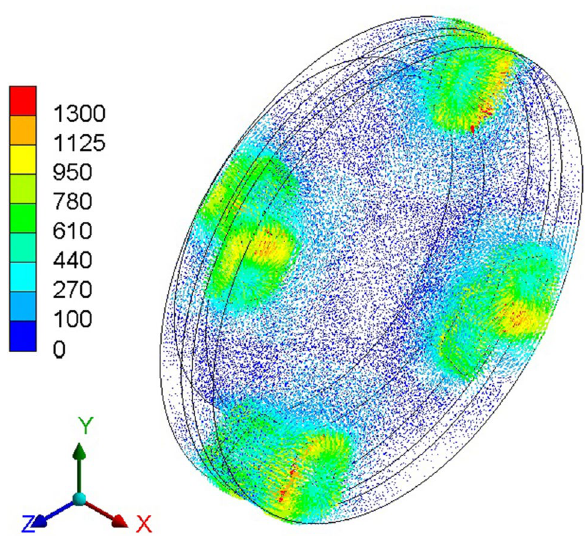
Fig. 7 Results of the magnetostatic simulation for gap 3 mm, Total magnetic flux density in mT . Maximum stop torque is 0.85 Nm